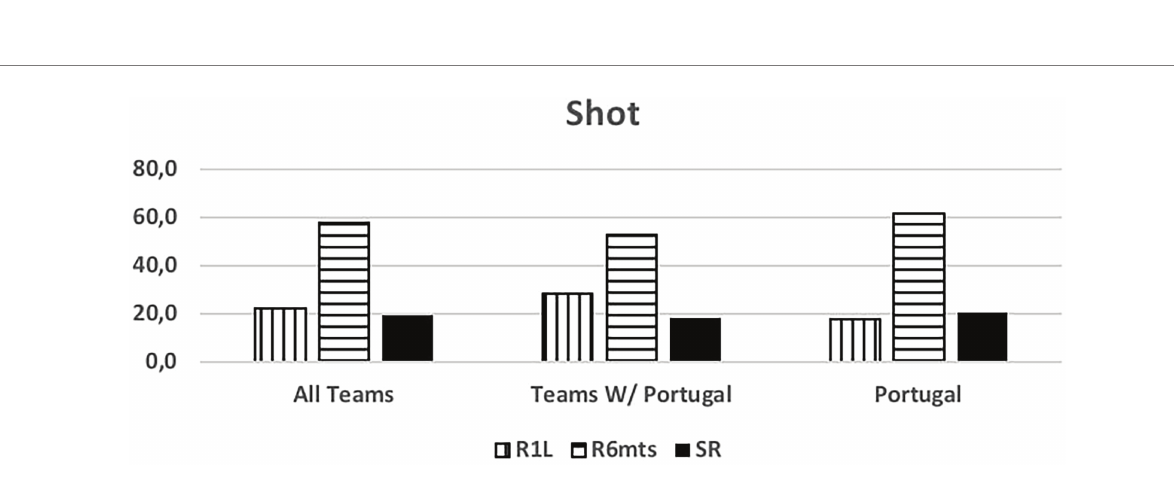
FIGURE 4 Shot. R1L, 9 m shot; R6mts, 6 m shot; SR, no